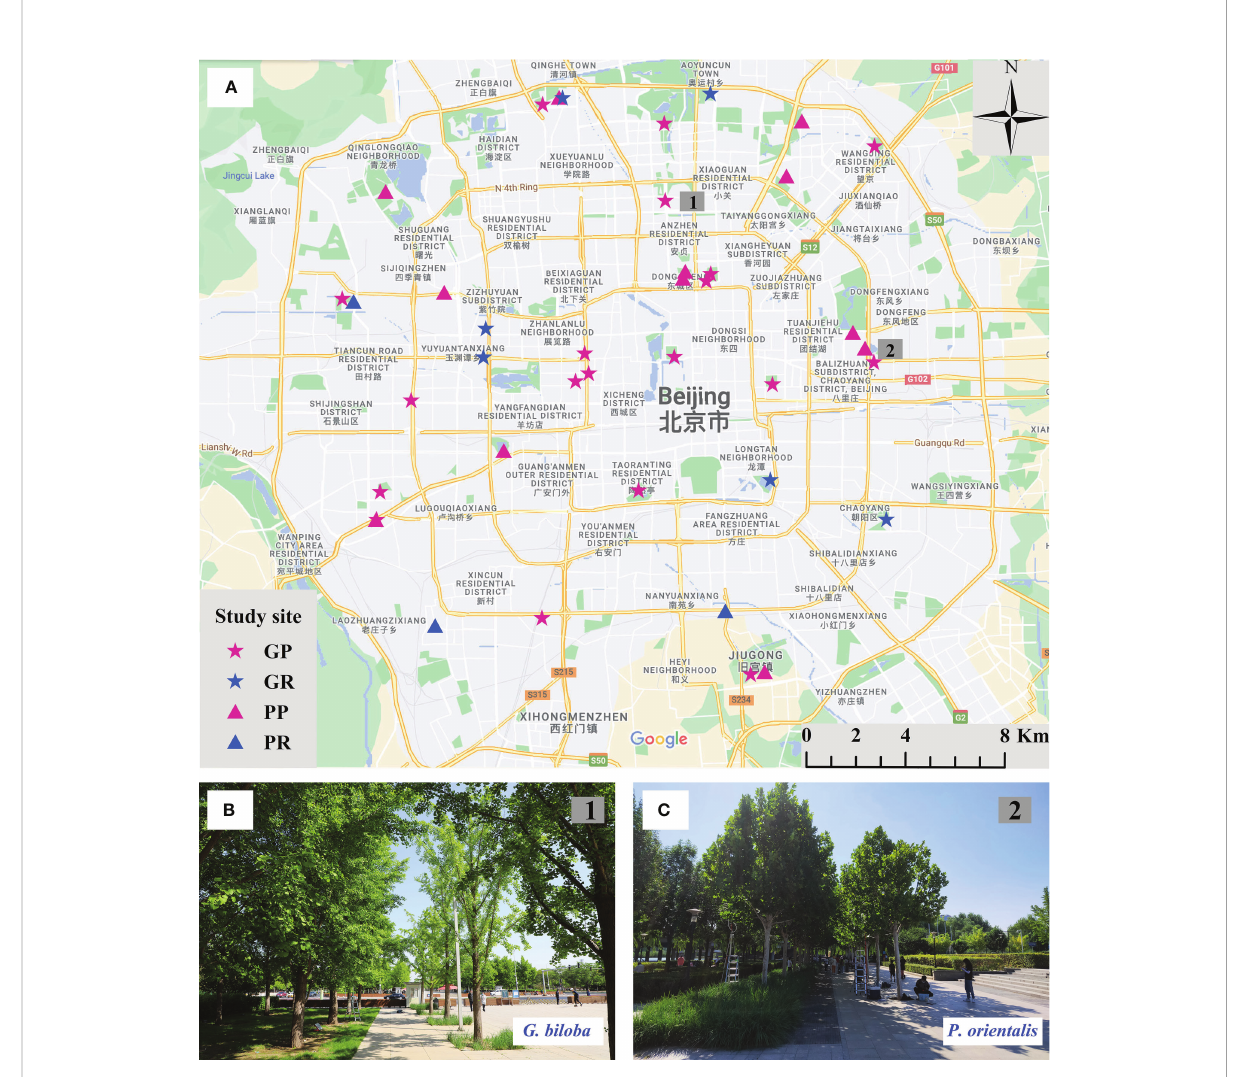
FIGURE 1 Location of the 40 study sites (A) for Ginkgo biloba at parks (GP) and at roadsides (GR) and for Platanus orientalis at parks (PP) and at roadsides (PR). Study sites of G biloba in Minzuyuan park (B) and P. orientalis in Honglingjin park (C) . At each study site, trees grow at adjacently paired plots: vegetated land and paved